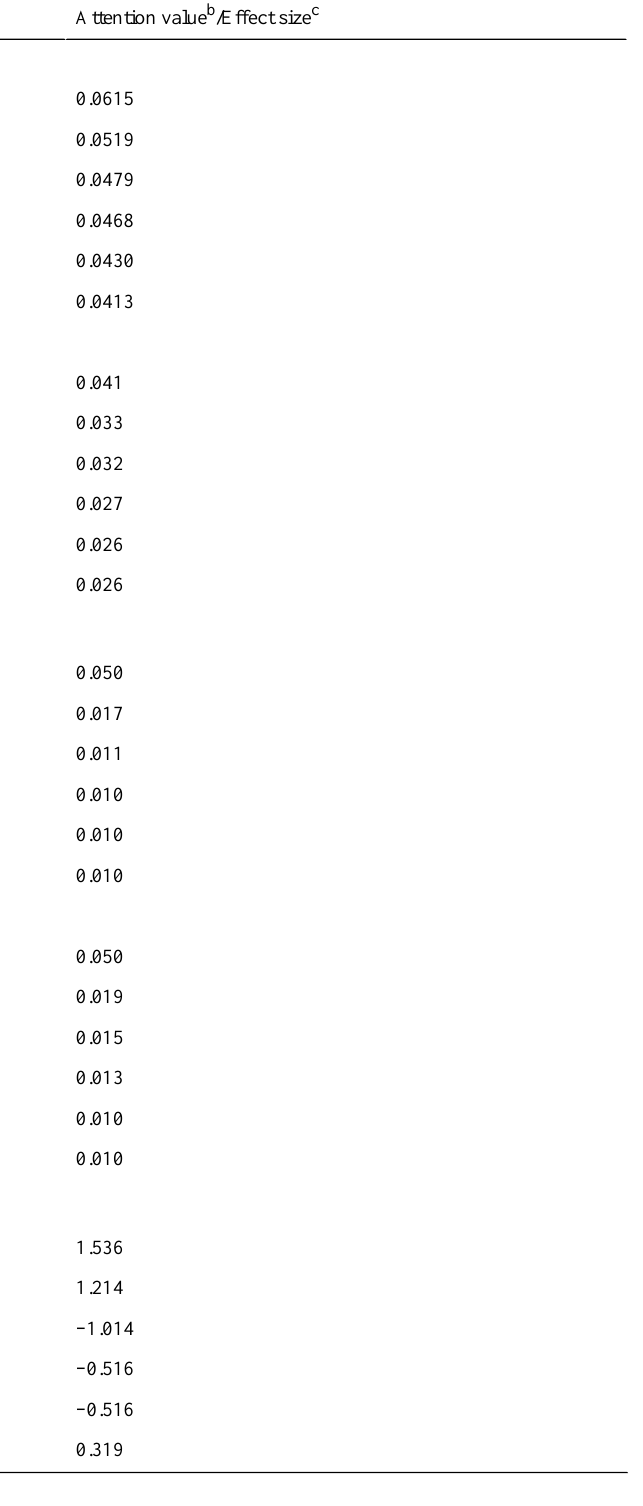
Table 2. Top 5% variable importance results estimated by different